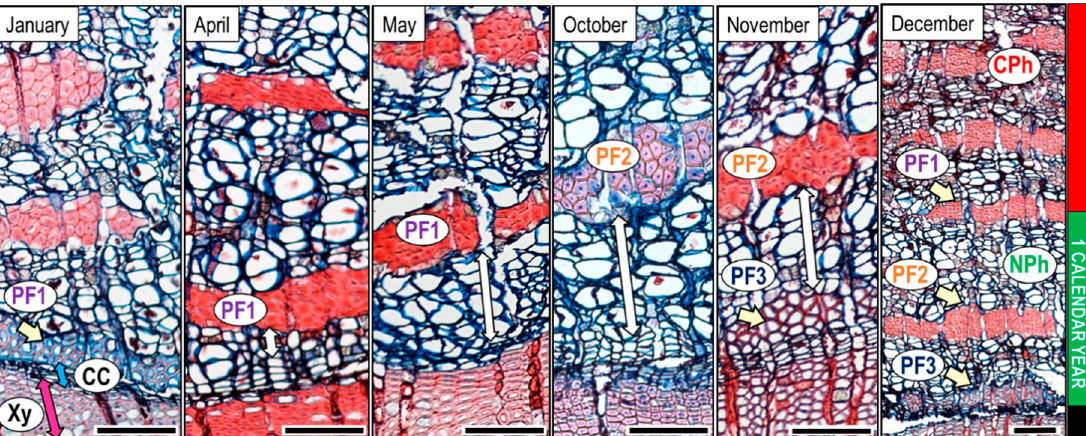
Figure 7. Wood, cambium, and phloem with fibre groups (PF) in January, April, May, October, November, and December in tree number 7. PF1, PF2, and PF3 serve as an orientation to evaluate the amount of phloem formed from January by the sampling date (white arrows with double heads). The sample taken in December (right image) contains non-collapsed phloem (NPh) with three groups of fibres which corresponds with the amount of phloem formed in one calendar year, 2017; the phloem formed in the previous year is already collapsed (CPh). Scale bar = 100 μ m.